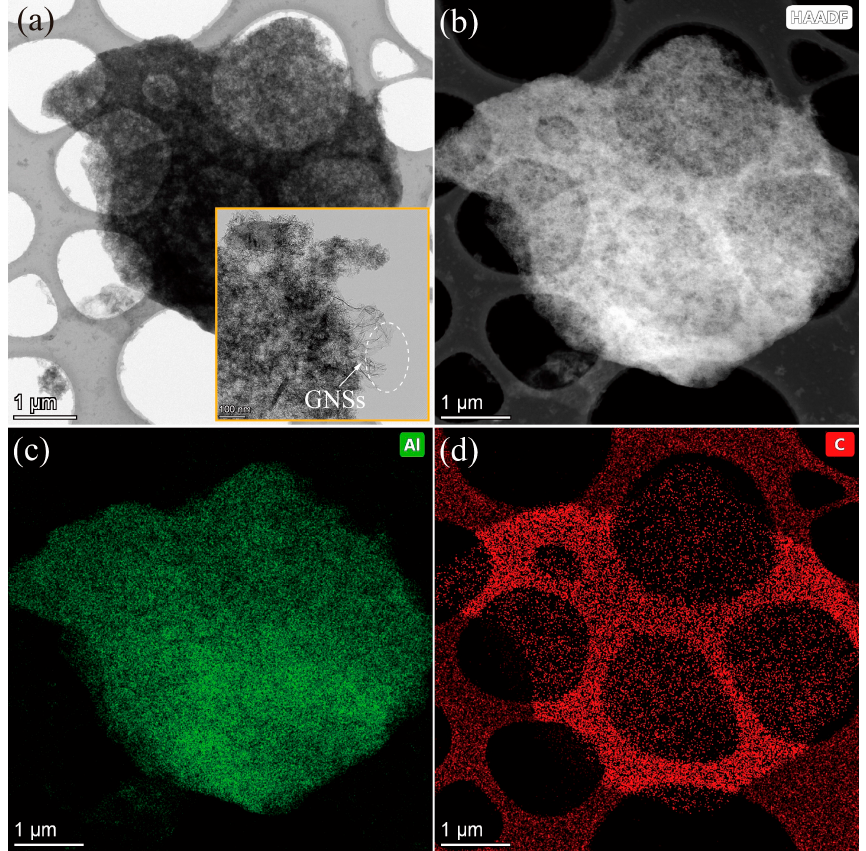
Figure 8. TEM image of GNS/Al composite powders: bright TEM image ( a ); HAADF image ( b ). EDS maps of Al ( c ) and C ( d ).